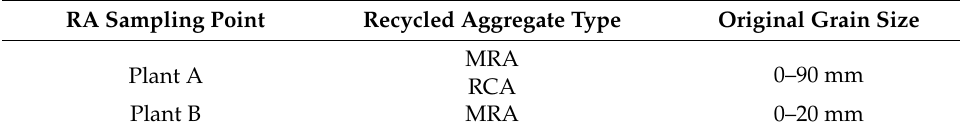
Table 1. Origin, type, and dimension of the recycled aggregates sampled.